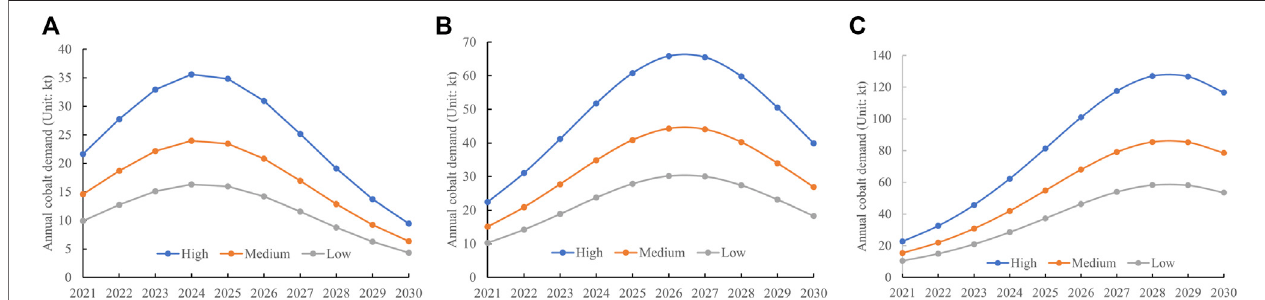
FIGURE 2 | Annual cobalt demand for EVs under different scenarios. (A) shows the cobalt demand for the pessimistic market potential scenario; (B) is for the baselinemarket potential scenario; (C) isfortheoptimisticmarket potentialscenario.Inthelegend, Highdenotes thehighcobaltscenario,Medium denotes themedium cobaltscenario,andLowrepresents thelowcobaltscenario.This fi gureplotsthehighscenarioofternarylithiumbatterymarketshare(70%).Mediumandlowscenarios are provided in the ( Supplementary Figures S4, S5